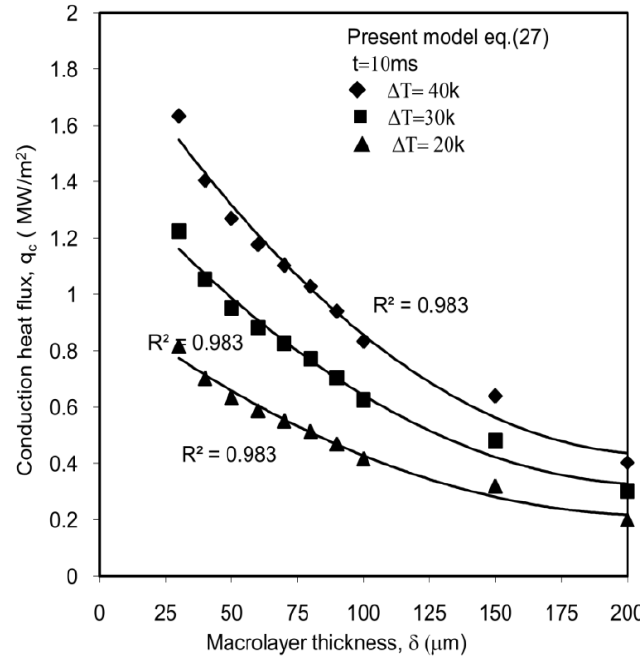
Figure 4. Effect of the macrolayer thickness on the heat flux for different superheats.